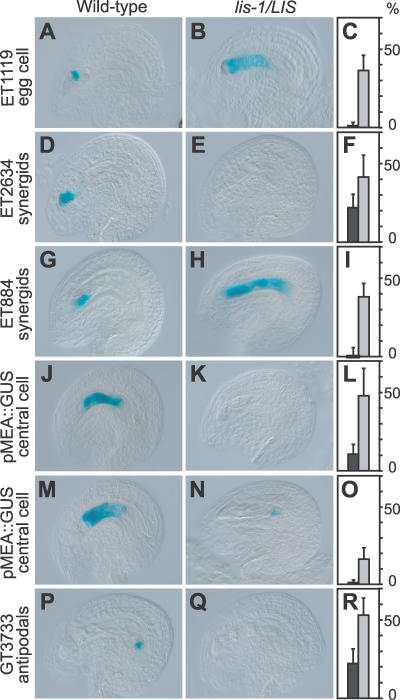
Molecular Analysis of lis-1 and Wild-Type GametophytesExpression analysis of cell-specific marker genes in wild-type versus lis-1/LIS plants (2 d after emasculation if not otherwise indicated). The onset of GUS expression for all markers is only detected after cellularization. (A, D, G, J, M, and P) The wild-type expression pattern for each marker. (B, E, H, K, N, and Q) Abnormal expression patterns, representing the scored phenotypes. (C, F, I, L, O, and R) Frequencies of abnormal patterns. Dark bars represent wild-type, light bars represent lis-1/LIS plants. The y-axis shows the percentage of the scored phenotype.(A–C) The egg cell marker ET1119 was expressed ectopically in 36.4% of the gametophytes of lis-1/LIS plants (n = 562; wild-type: 1.2%, n = 423).(D–F) The synergid marker ET2634 was not expressed in 41.5% of lis-1/LIS gametophytes (n = 789; wild-type: 22.0%, n = 1,176).(G–I) The synergid marker ET884 was expressed ectopically in 38.7% of the gametophytes of lis-1/LIS plants (n = 694; wild-type: 0.1%, n = 1,055).(J–L) Expression of the central cell pMEA::GUS reporter construct was not detected in 47.8% of the gametophytes of lis-1/LIS plants (n = 596; wild-type: 10.7%, n = 428).(M–O) Ectopic expression of pMEA::GUS reporter construct in antipodal cells 3 d after emasculation was detected in 16.4% of the gametophytes of lis-1/LIS plants (n = 531; wild-type: 1.3%, n = 468).(P–R) The antipodal marker GT3733 was not expressed in 53.1% of the gametophytes of lis-1/LIS plants (n = 715; wild-type: 22.2%, n = 1,283).